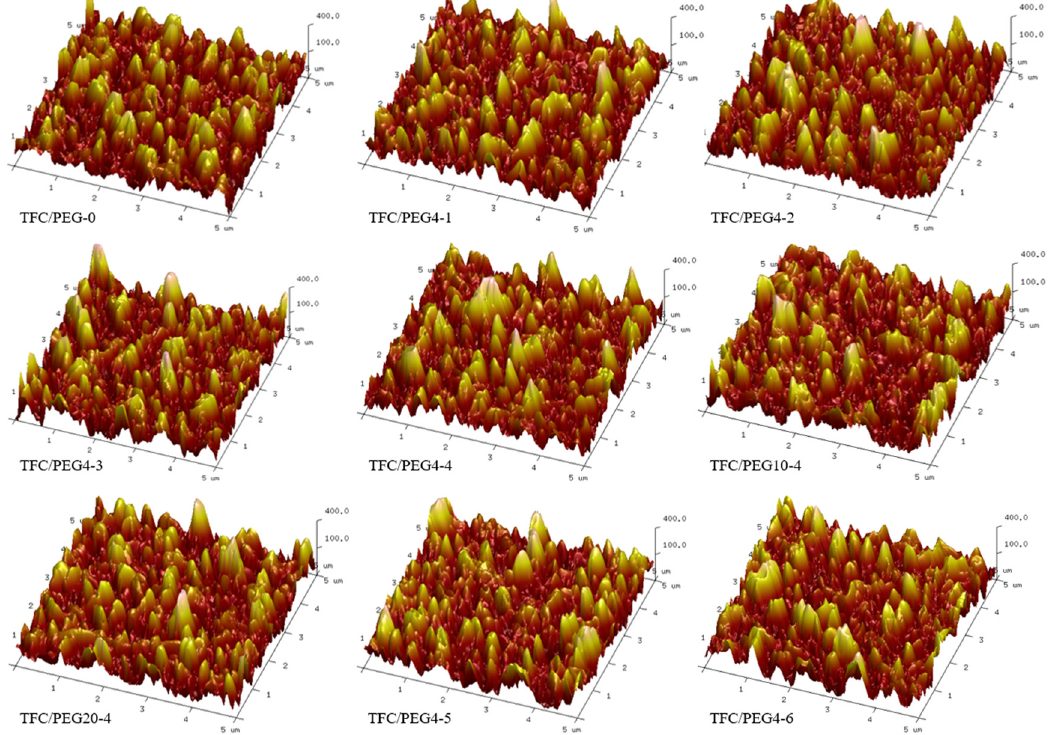
Figure 9. AFM images for PSU/PEG supported TFC-FO membranes.